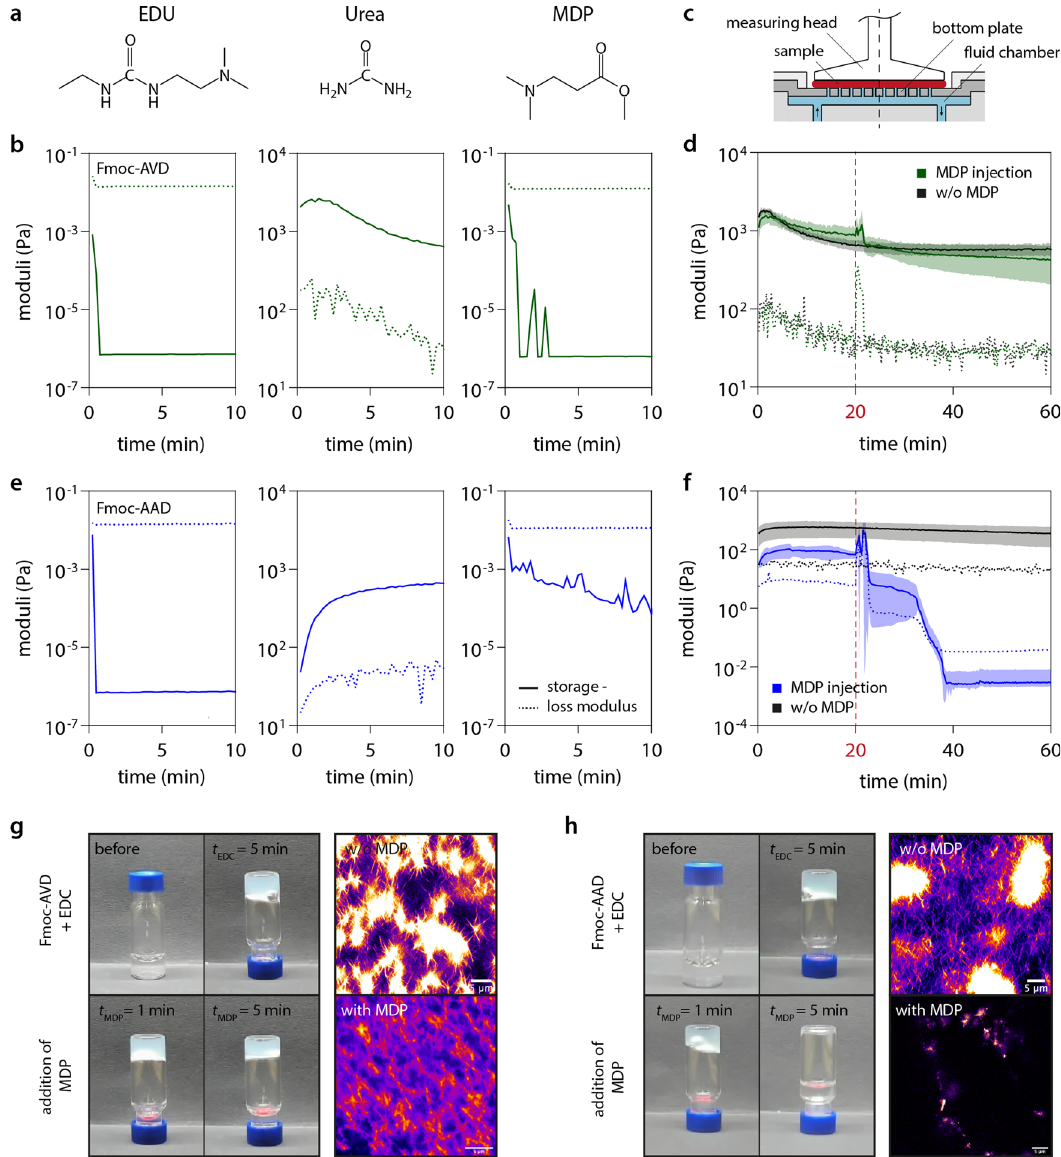
Fig. 4 In fl uence of reaction side products on the viscoelastic properties of chemically fueled hydrogels. The waste product of the reaction cycle (EDU) and its structural mimetics ( a ) affect the gelation behavior of Fmoc-AVD (green) and Fmoc-AAD (blue) differently ( b , e ). Custom-made rheological setup to assess the behavior of preformed gels when brought into contact with the waste-mimetic MDP ( c ): here, the viscoelastic properties of a preformed Fmoc-AVD gel exposed to MDP after 20 min (dashed red line) remain virtually unaffected ( d ). However, a preformed Fmoc-AAD gel disintegrates upon exposure to MPD ( f ). Reference measurements without the addition of MDP are illustrated in gray for both peptide systems. Data shown represents the mean as obtained from n ≥ 3 independent samples. Error bands ( d , f ) depict the standard deviation. Inverted tube tests and fl uorescent imaging of Fmoc- AVD ( g ) and Fmoc-AAD ( h ) samples further illustrate gel formation and gel (in)stability after MPD